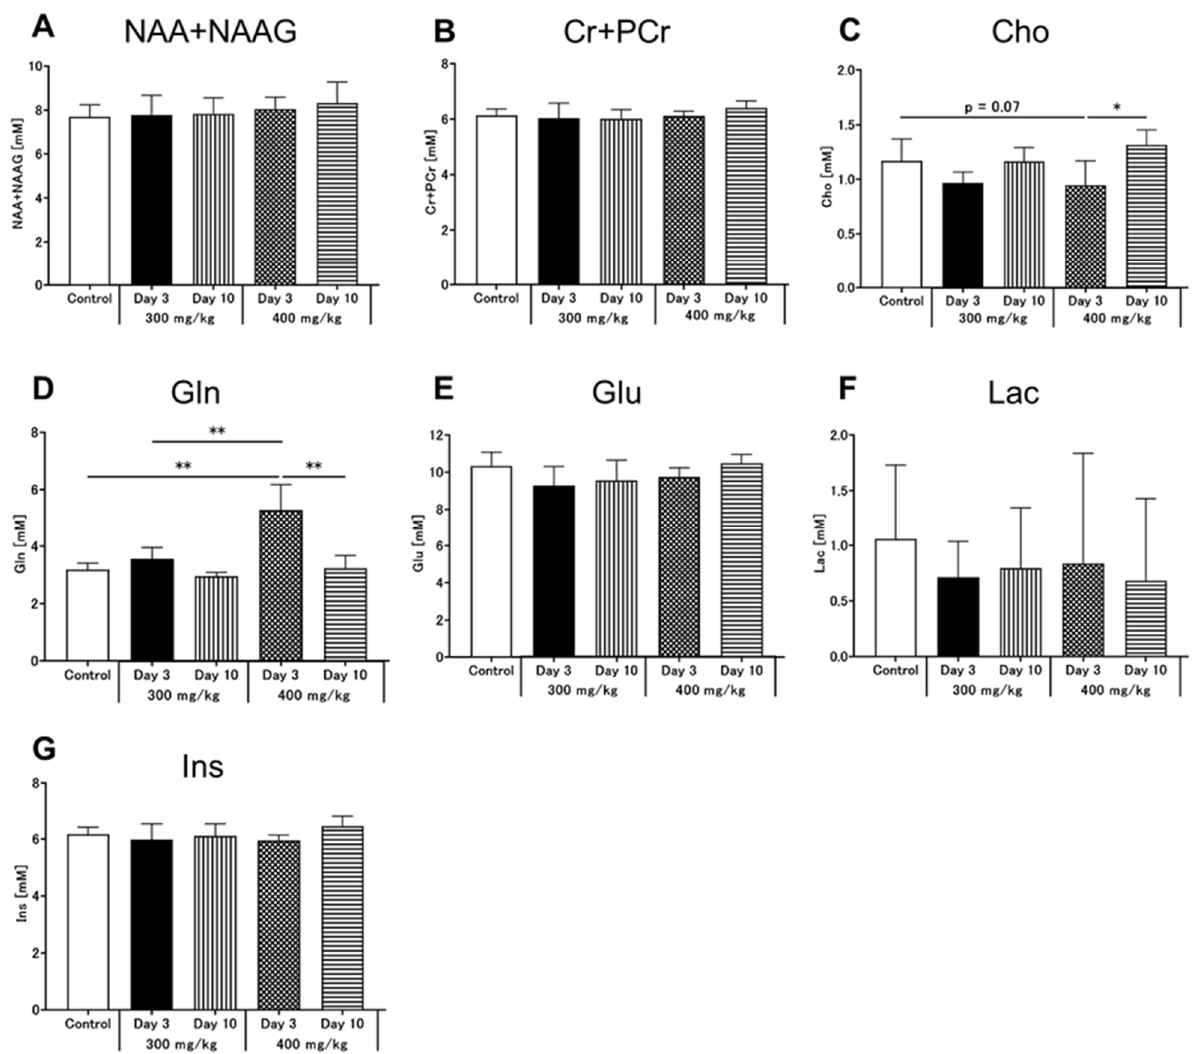
Figure 5. Results of the 1 H MRS analyses. Data are presented as the mean ± standard deviation. Significance levels in comparison to control rats: * p < 0.05, ** p < 0.01. 1 H MRS, proton magnetic resonance spectroscopy; ( A ) NAA + NAAG, N-acetylaspartate + N-acetylaspartylglutamate; ( B ) Cr + PCr, creatine + phosphocreatine; ( C ) Cho, choline; ( D ) Gln, glutamine; ( E ) Glu, glutamate; ( F ) Lac,